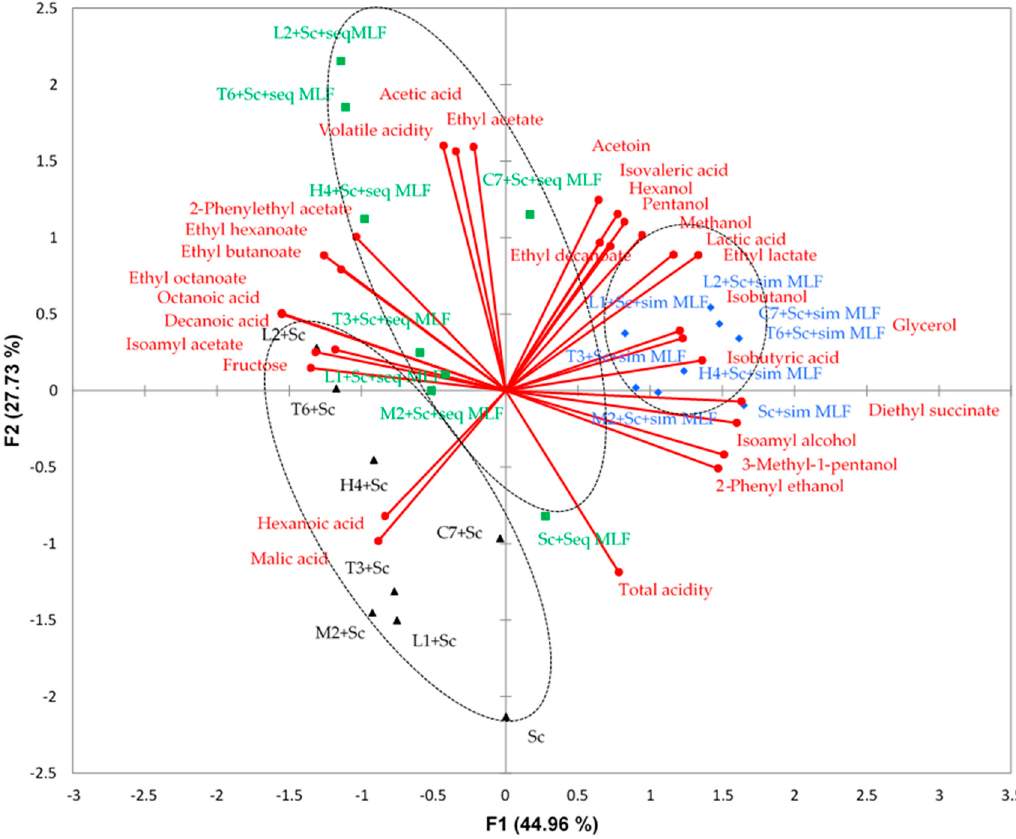
Figure 3. Principal component analysis (PCA) bi-plot derived from volatile compounds and standard chemical parameters of Shiraz wines produced with Saccharomyces cerevisiae (Sc) on its own or in combination with Candida zemplinina C7, Hanseniaspora uvarum H4, Lachancea thermotolerans strains L1 and L2, Metschnikowia pulcherrima M2 and Torulaspora delbrueckii strains T3 and T6, as well as three malolactic fermentation (MLF) strategies (none, simultaneous and sequential). Circles are for illustrative purpose only.